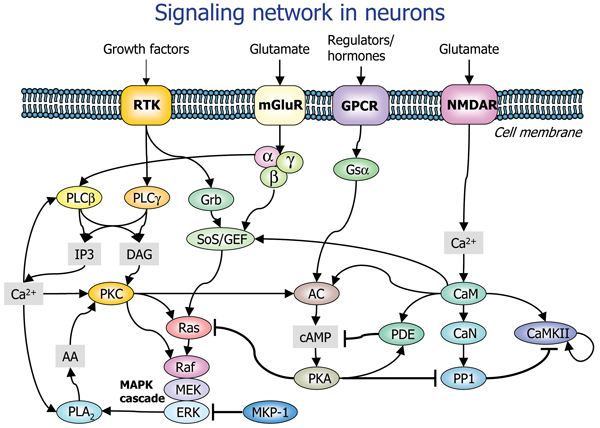
Signaling network in neurons Schematic overview of signaling pathway modules in neuronal cells (redrawn from Bhalla [82]). Abbreviations: RTK: receptor tyrosine kinase; mGluR: metabotropic glutamate recptor; GPCR: G-protein coupled receptor; NMDAR: N-methyl D-aspartate Receptor; Gq: G-protein type q; Gsα: G-protein type s; PLCβ: phospholipase C β; PLCγ: phospholipase C γ; IP3: inositol trisphosphate; DAG: diacylglycerol; Sos/GEF: Son of Sevenless/guanine nucleotide exchange factor; Ca2+ : Calcium; PKC: protein kinase C; AC: adenylyl cyclase; PDE: phosphodiesterase; CaM: calmodulin; CaMKII: calcium calmodulin kinase type II; cAMP: cyclic adenosine monophosphate; CaN: calcineurin; AA: arachidonic acid; PLA2: phospholipase A2; MAPK: mitogen activated protein kinase; MKP-1: MAP-Kinase phosphatase type 1; PKA: protein kinase A; PP1: protein phosphatase type 1.